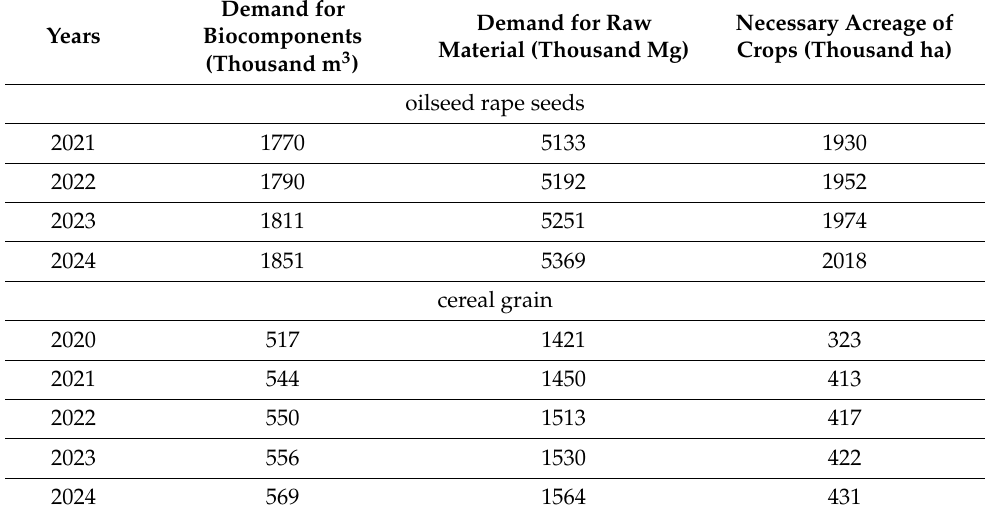
Table 3. Predicted demand for seeds of oilseed rape grown for energy purposes and grain for the production of